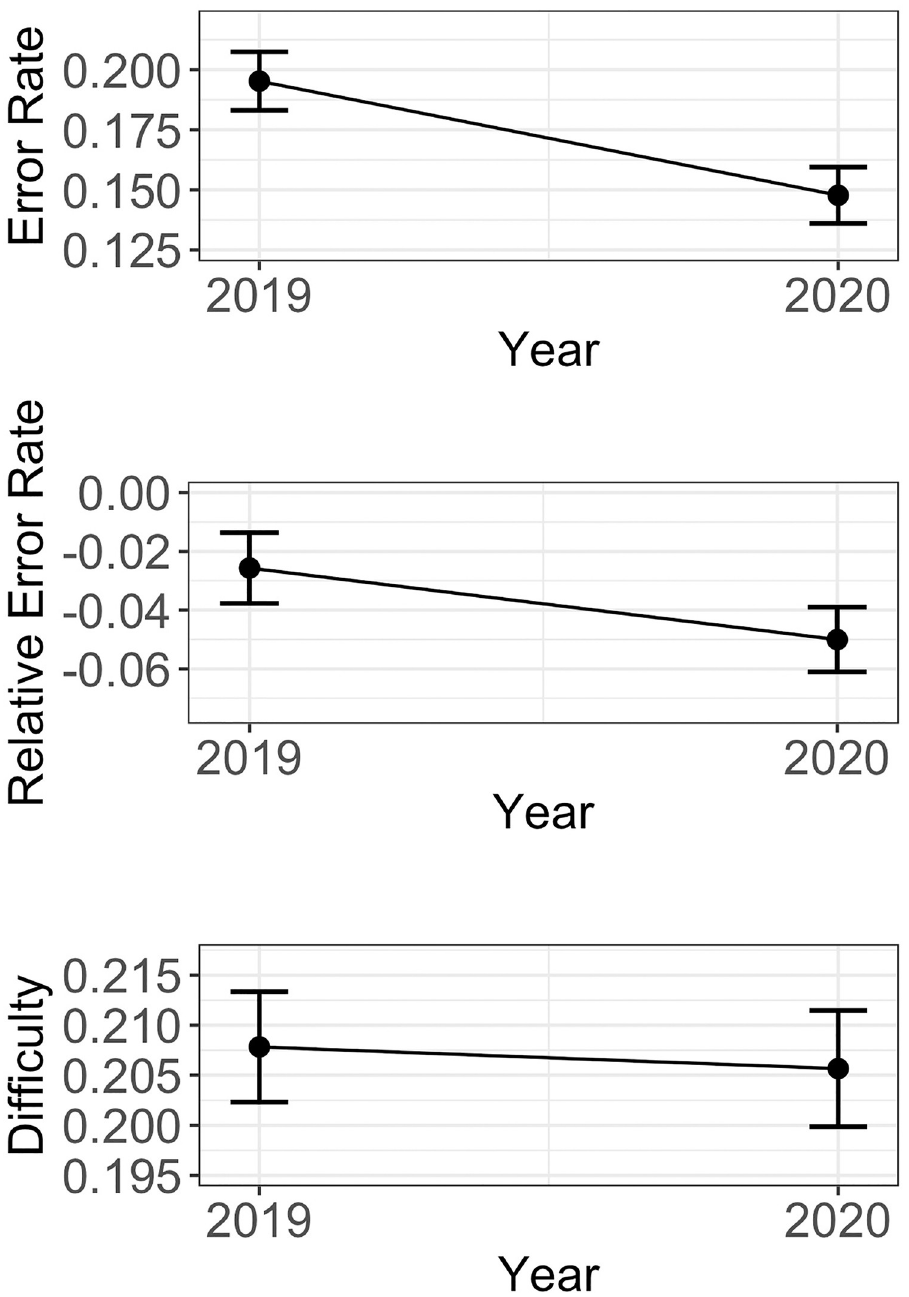
Fig 3. Estimates of absolute error rate, relative error rate and problem set difficulty as a function of time. Results from the Analyses 1a-c are depicted. Error rates and relative error rates significantly decreases during the shutdown compared to the same time in the previous year. There was no significant difference in problem set difficulty between the two time windows. Points indicate mean estimates, error bars indicate the standard errors of the mean across students. Connected lines denote that both time windows include results from the same